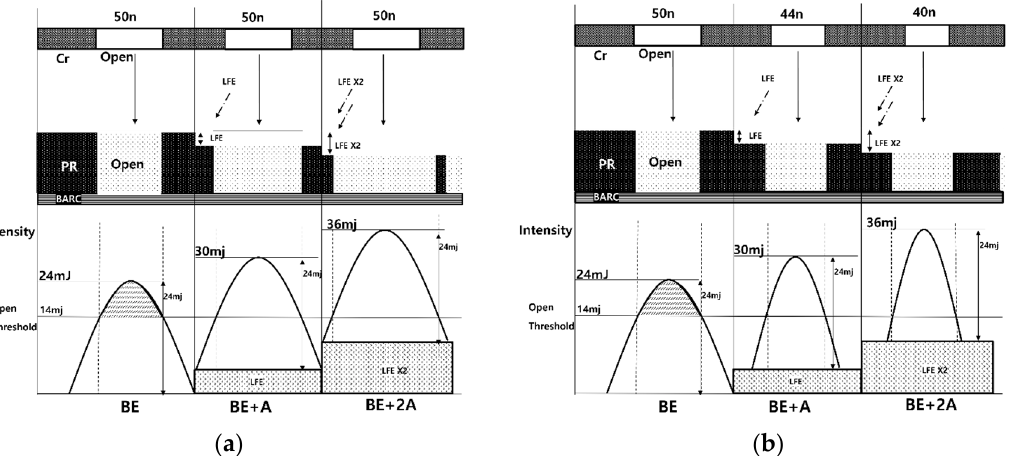
Figure 7. Intensity (DOSE + Flare) simulation of PR activation and PR activation according to the mask open ratio, ( a ) without OPC and ( b ) with